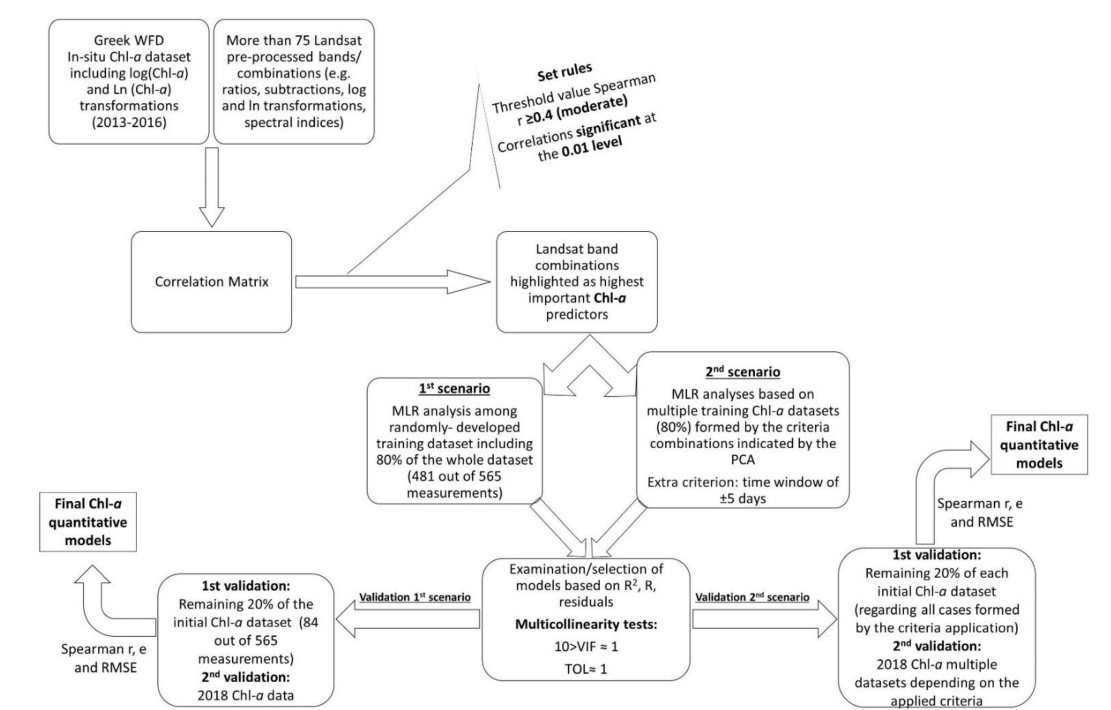
Figure 2. Flowchart summarizing the methodology followed in this